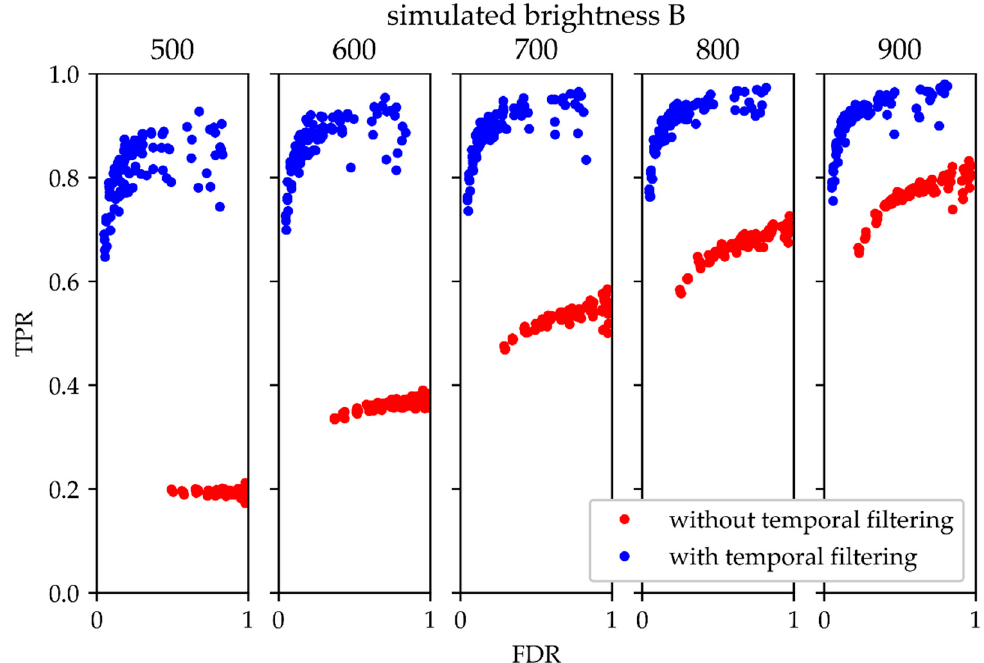
Figure 7. Performance test for the temporal filtering. The true positive rate (TPR) is plotted versus the false discovery rate (FDR) for different simulated single molecule brightness values. The comparison shows data obtained without (red) and with (blue) temporal filtering. In this plot, the top left corner corresponds to the ideal case with no false positive or negative signals, whereas the bottom right corner corresponds to the worst case of only false positive signals. Data include simulations with varied parameters for τ on and τ off . ω T was set to 80%, analyzed with the algorithm by Gao et al. [23]. The key point of localization microscopy is to achieve a high accuracy in localizing molecules, defined as the distance between the determined position of the detected signal and ground